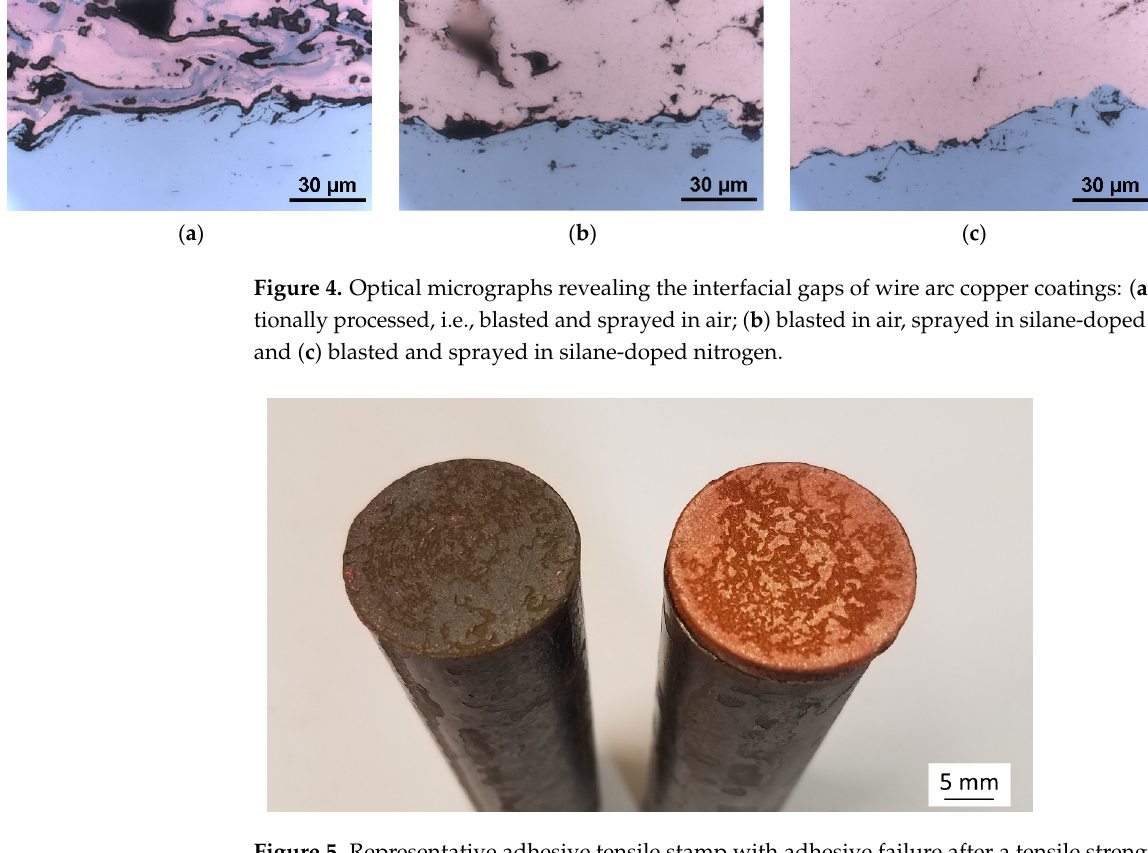
Figure 5. Representative adhesive tensile stamp with adhesive failure after a tensile strength test.